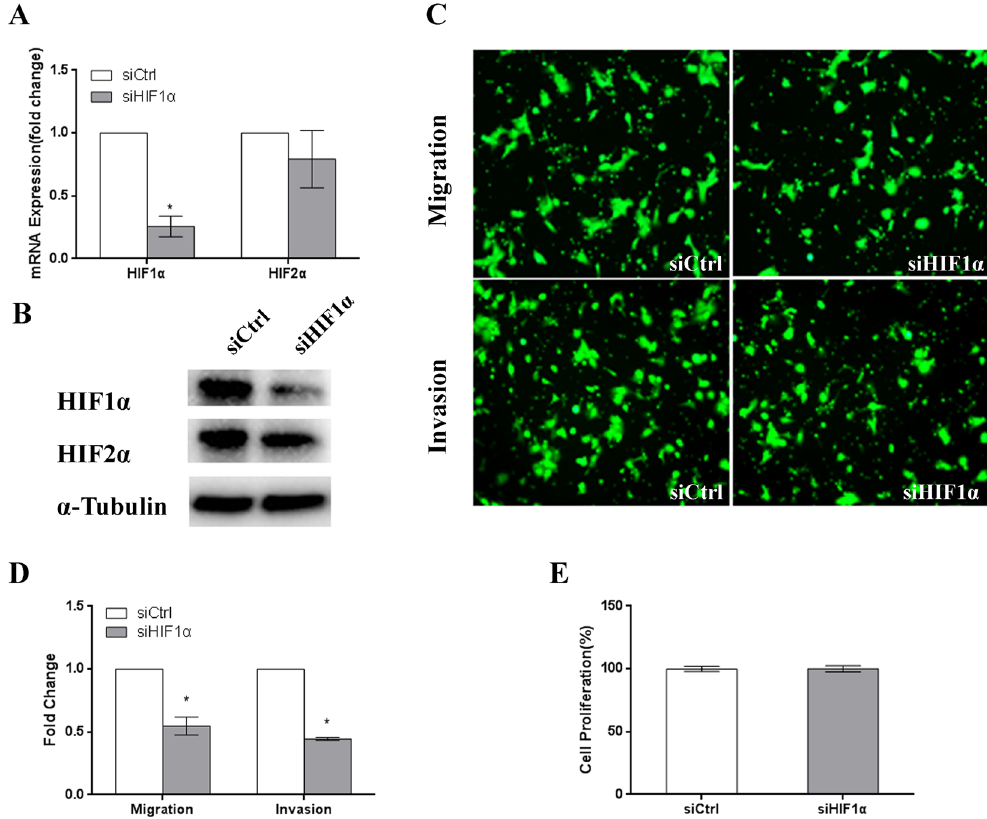
Figure-6. The migration, invasion and proliferation capacities of JEG3 cells are suppressed by HIF1 α knockdown in cells exposed to 3% O 2 . ( A , B ) Real-time PCR and western blot analyses showing the specific knockdown of HIF1 α in JEG3 cells by siRNA. ( C ) The migration and invasion capacities of JEG3 cells transfected with scramble (control) siRNA or HIF1 α siRNA. ( D ) The number of migrated or invaded cells was counted and the quantitative data are expressed as the fold change from the control of three independent experiments. ( * P < 0.05, ** P < 0.01, Student’s t-test) ( E ) The proliferation capacity of JEG3 cells with transfected with scramble (control) siRNA or HIF1 α siRNA for 48 h. (not significant, Student’s